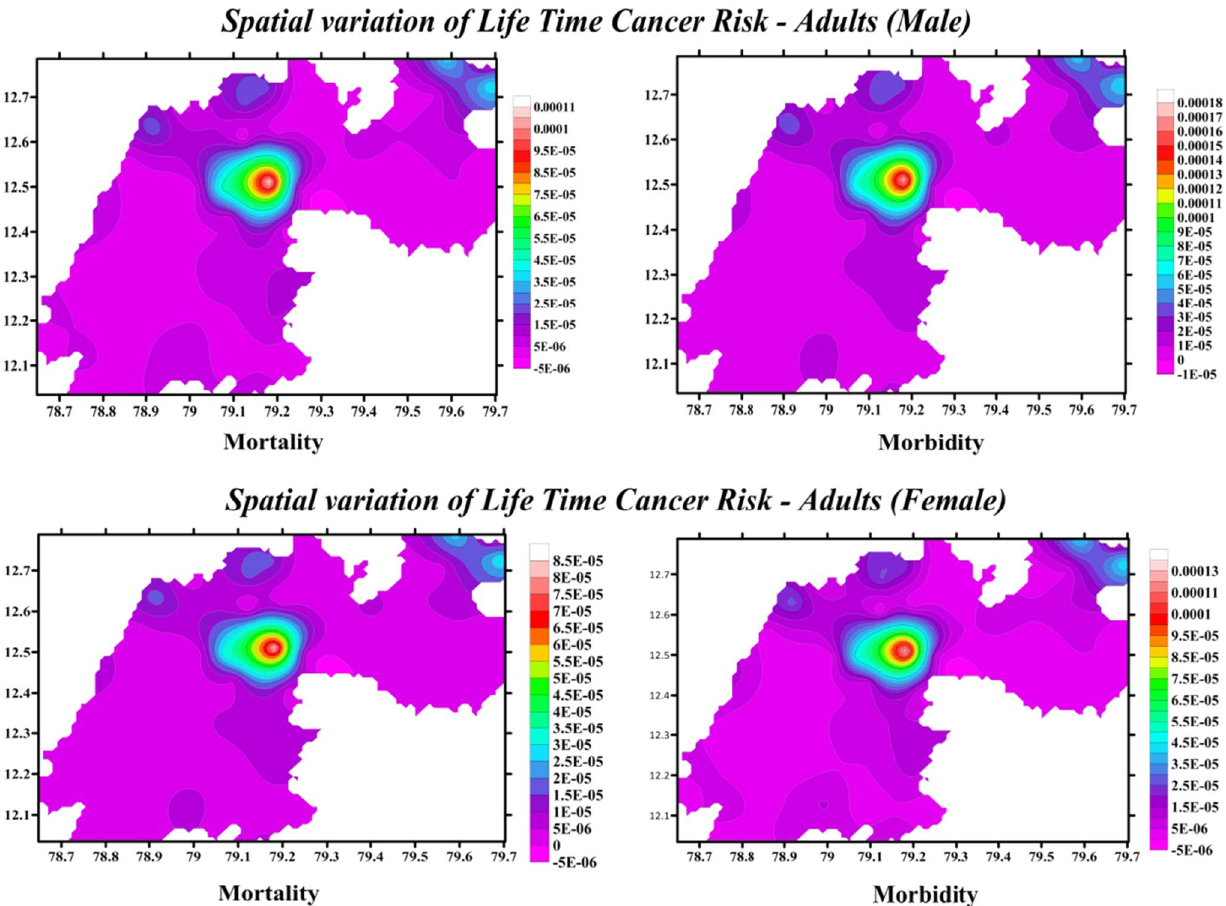
Fig. 28 Spatial distribution of life time cancer risk in the study